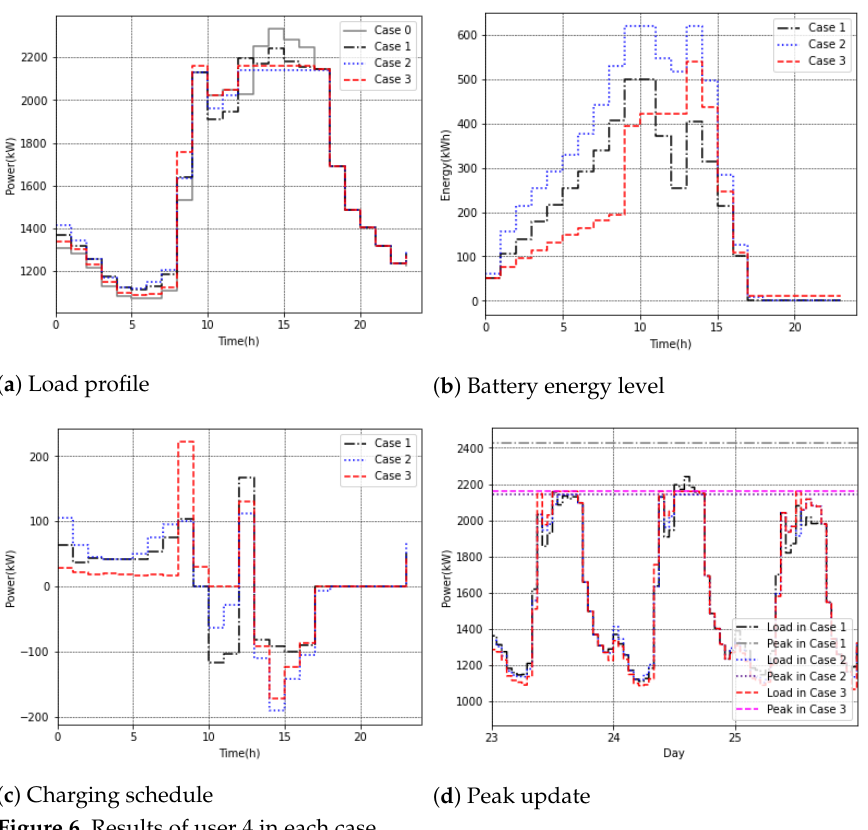
Figure 6. Results of user 4 in each